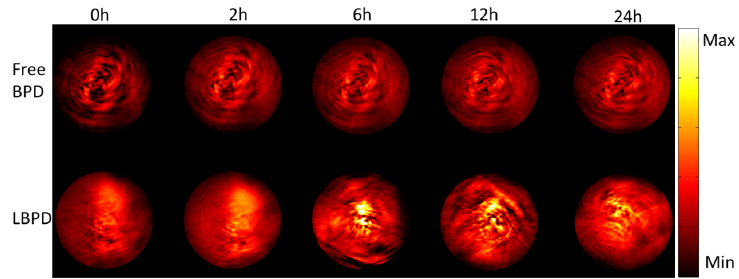
Fig. 6. PA images of the tumor sites at di®erent time point with free BPD and LBPD under 698 nm pulse laser with the incident optical °uence of 10 mJcm (cid:2) 2